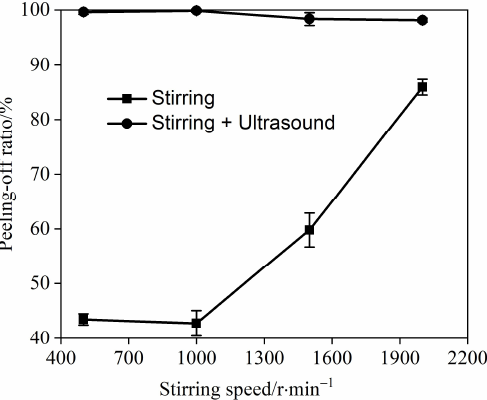
Figure 9. Effect of mechanical stirring speed on peeling-off ratio of ultrasound-mechanical stirrer.